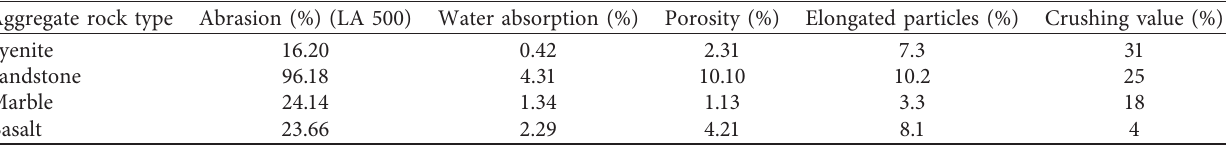
Table 7: Aggregate technical index.